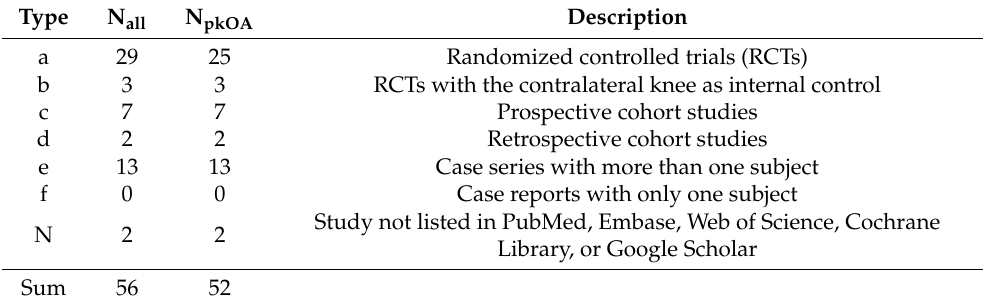
Table 2. Types of studies included in the meta-analyses summarized in Table S2, which details clinical studies in which management of primary knee osteoarthritis with stem cells was